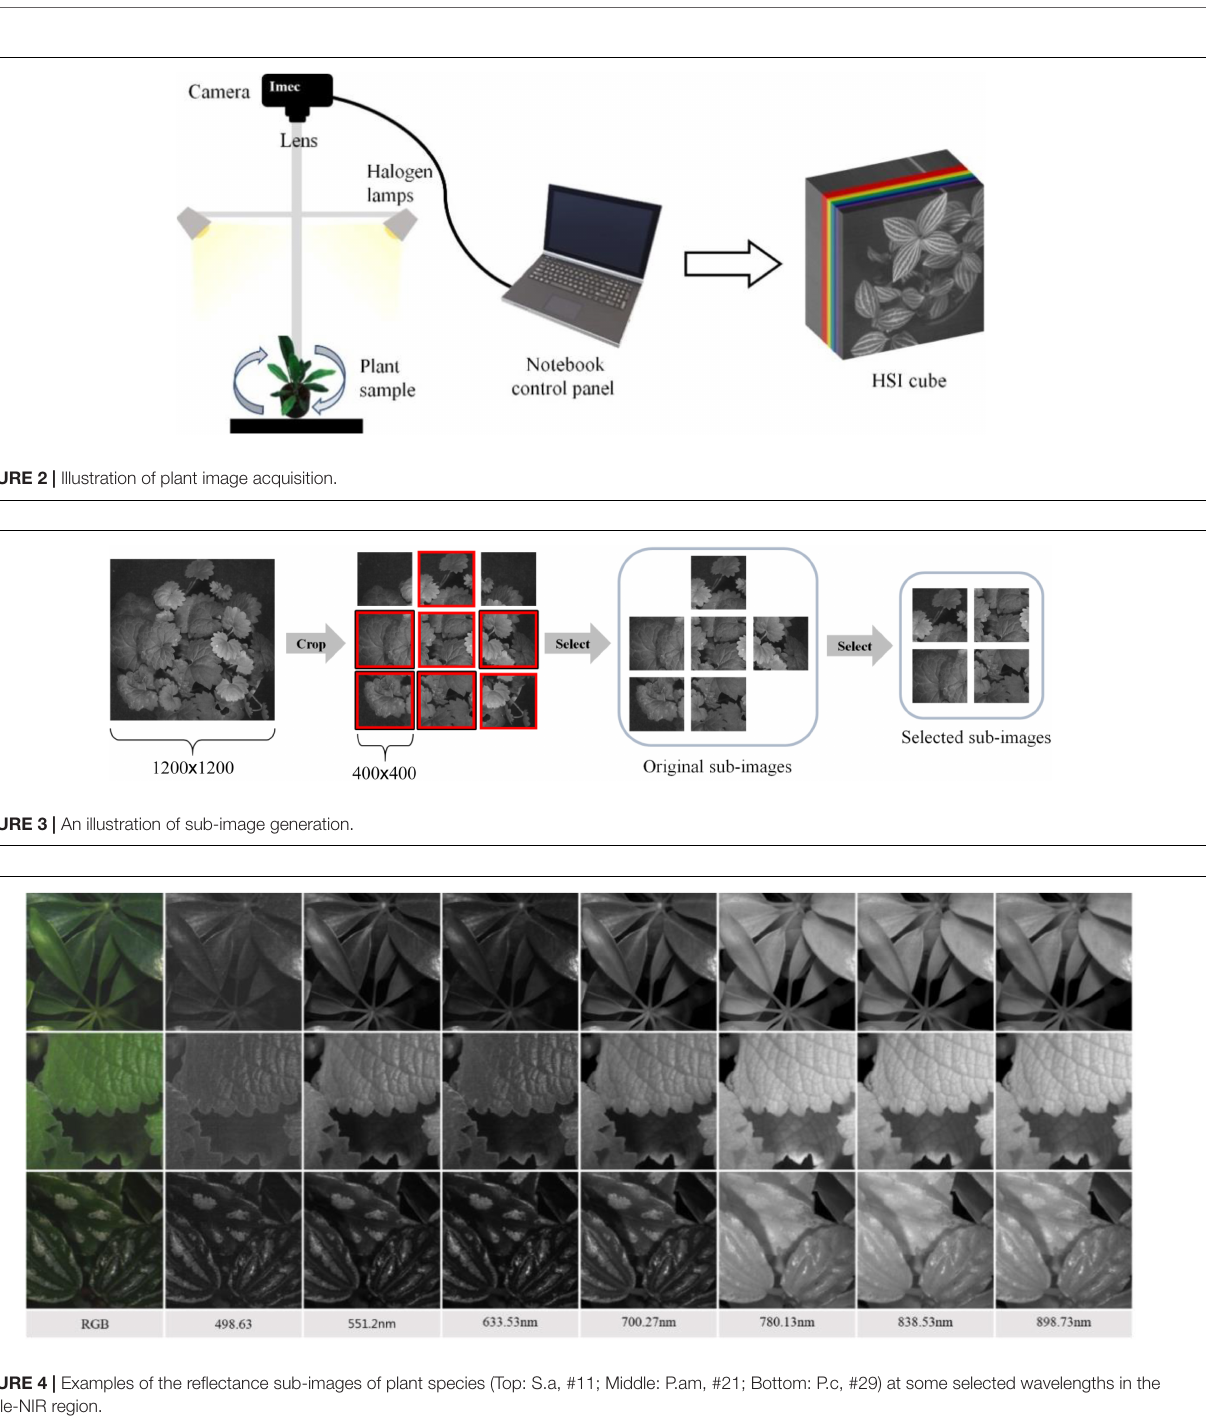
horizontal or vertical to expand the size of the training